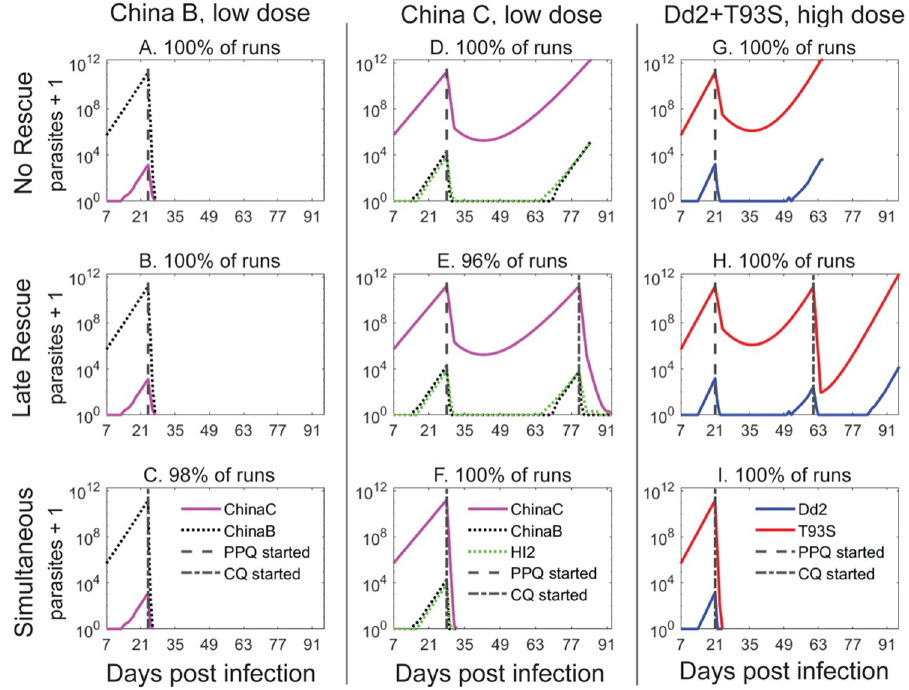
Fig 5. Evolutionary simulations of empirically determined fitness landscapes with pfcrt China alleles or PPQ- resistant Dd2+T93S. Representative simulation results starting with infection by a monoculture of PPQ-sensitive Dd2 China B parasites followed by initial treatment with a low-dose regimen of 200 nM PPQ as ( A ) monotherapy; ( B ) plus late rescue with 125 nM CQ; or ( C ) as simultaneous PPQ and CQ combination treatment. Late rescue was not triggered given no parasites survived. Representative simulation results starting with PPQ-resistant Dd2 China C parasites followed by initial treatment with 200 nM PPQ as ( D ) monotherapy; ( E ) plus late rescue with 125 nM CQ; or ( F ) simultaneous PPQ and CQ combination treatment. Representative simulation results starting with PPQ-resistant Dd2 Dd2+T93S parasites followed by initial treatment with a high-dose regimen of 400 nM PPQ as ( G ) monotherapy; ( H ) plus late rescue with 250 nM CQ; or ( I ) simultaneous PPQ and CQ treatment. 100 stochastic simulations were run for each condition, with the percentage frequencies listed for particular outcomes. Dashed vertical lines indicate initiation of each three-day dosing. Results are summarized in Tables 2 and